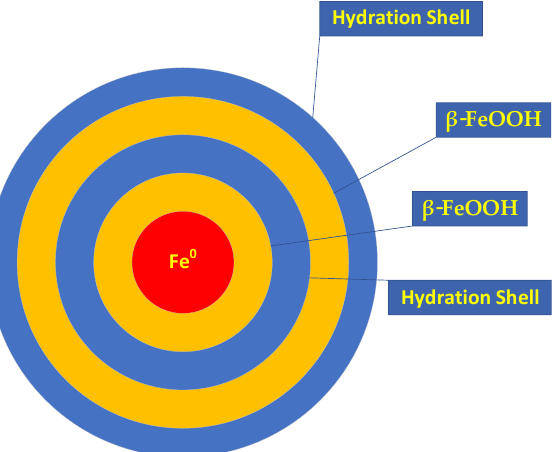
Figure 10. Initial n-Fe 0 oxidation to provide a hydrated polymer coating.